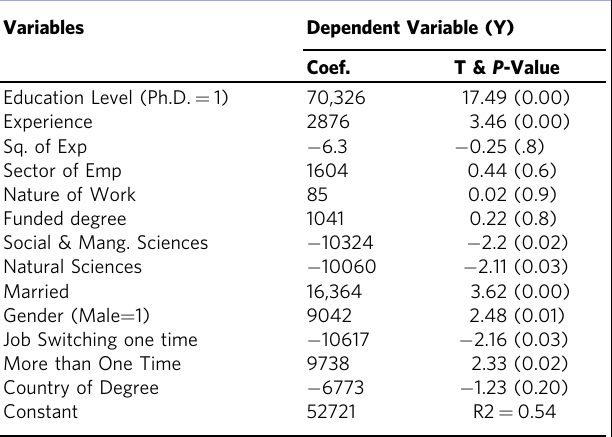
Table 6 Level of education, experience, nature of work, and